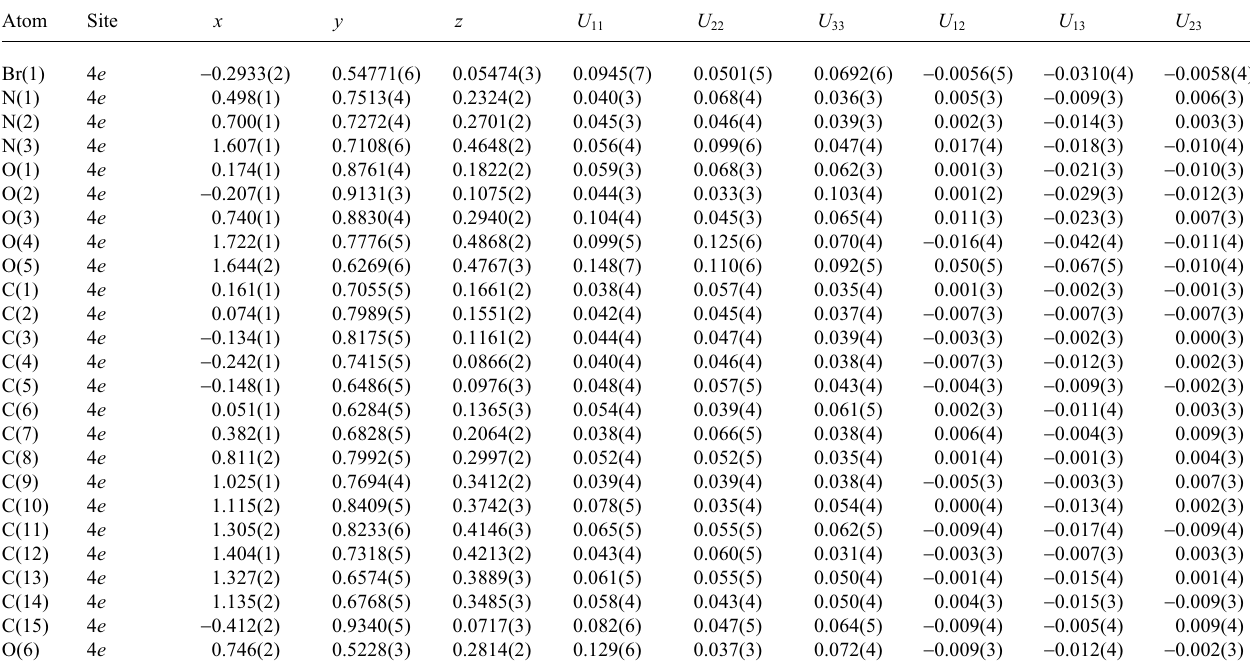
Table 3. Atomic coordinates and displacement parameters (in Å 2 )